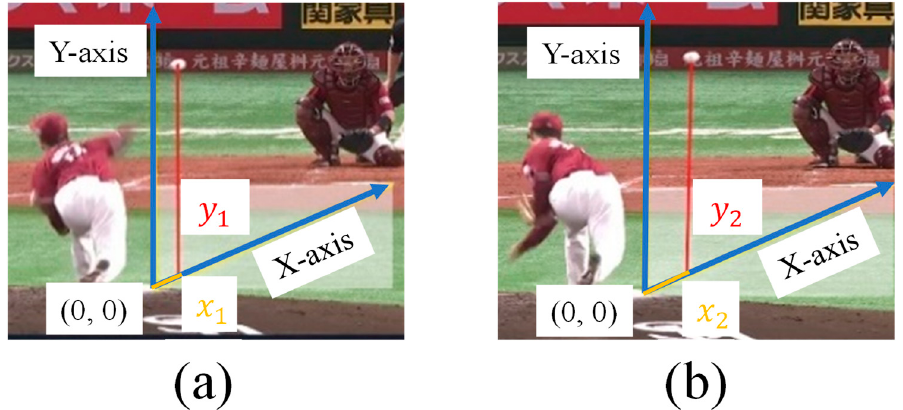
Figure 4. Schematic of the baseball flight at ( a ) t 1 and ( b ) t 2 .